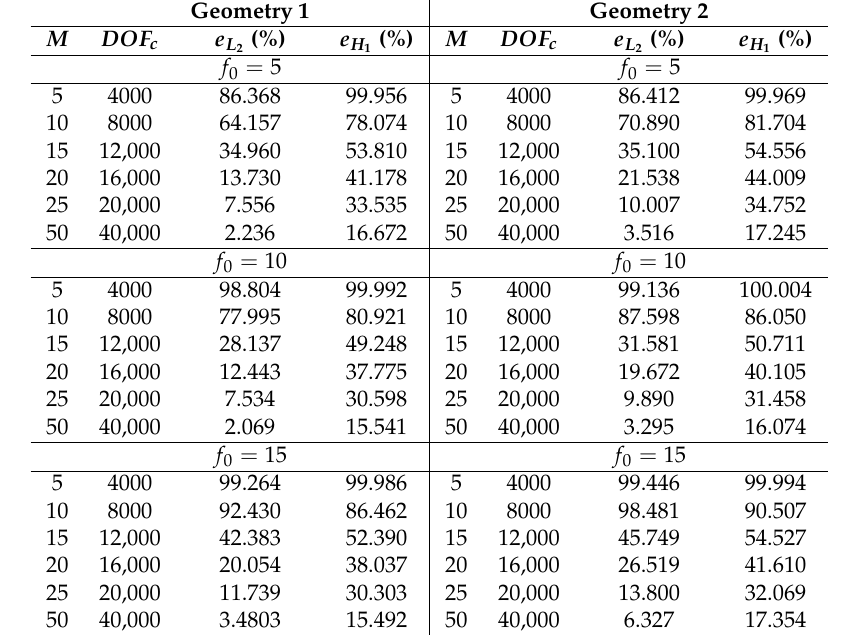
Table 2. Relative errors for Discontinuous Galerkin Generalized Multiscale Finite Element Method (DG-GMsFEM) with different number of multiscale basis functions M = M o = M b . Left: Geometry 1. Right: Geometry